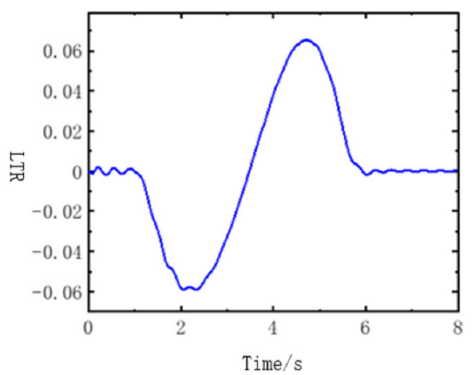
Figure 6. Co-simulation results. ( a ) Path tracking. ( b ) Yaw angle tracking. ( c ) Lateral acceleration. ( d ) Front-wheel turning angle.